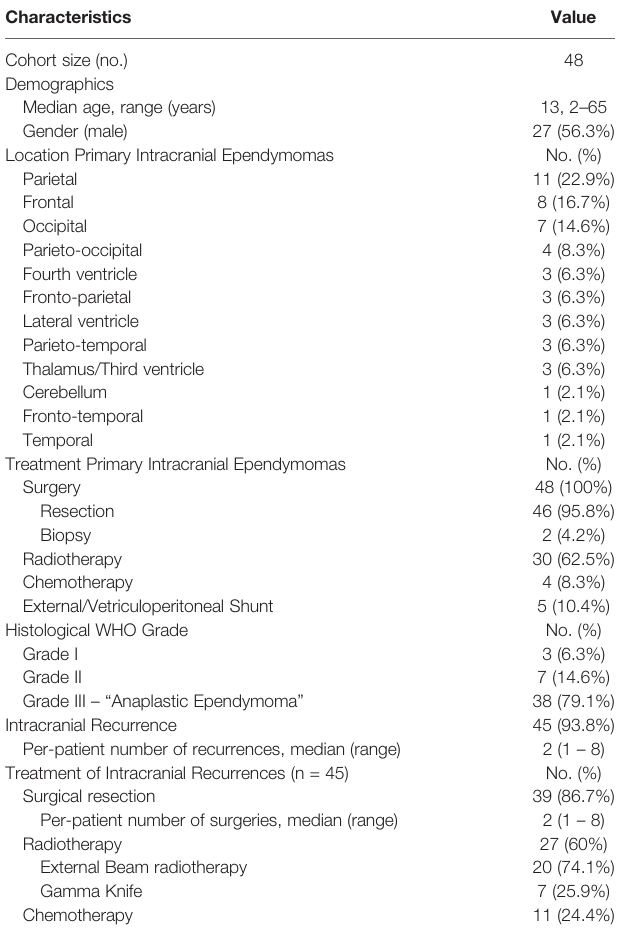
TABLE 2 | Summary of clinical characteristics and management strategies of all pooled primary intracranial ependymomas.